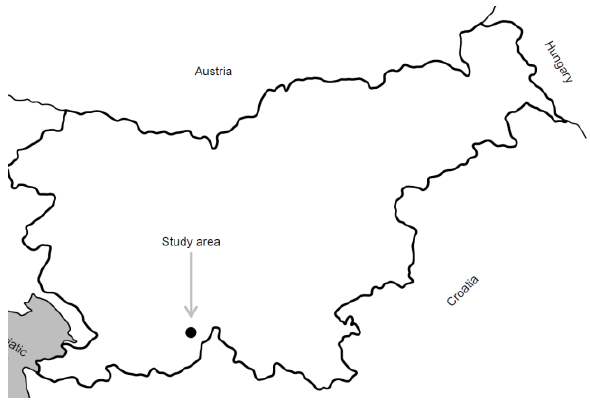
Figure 1. Study area in south-west